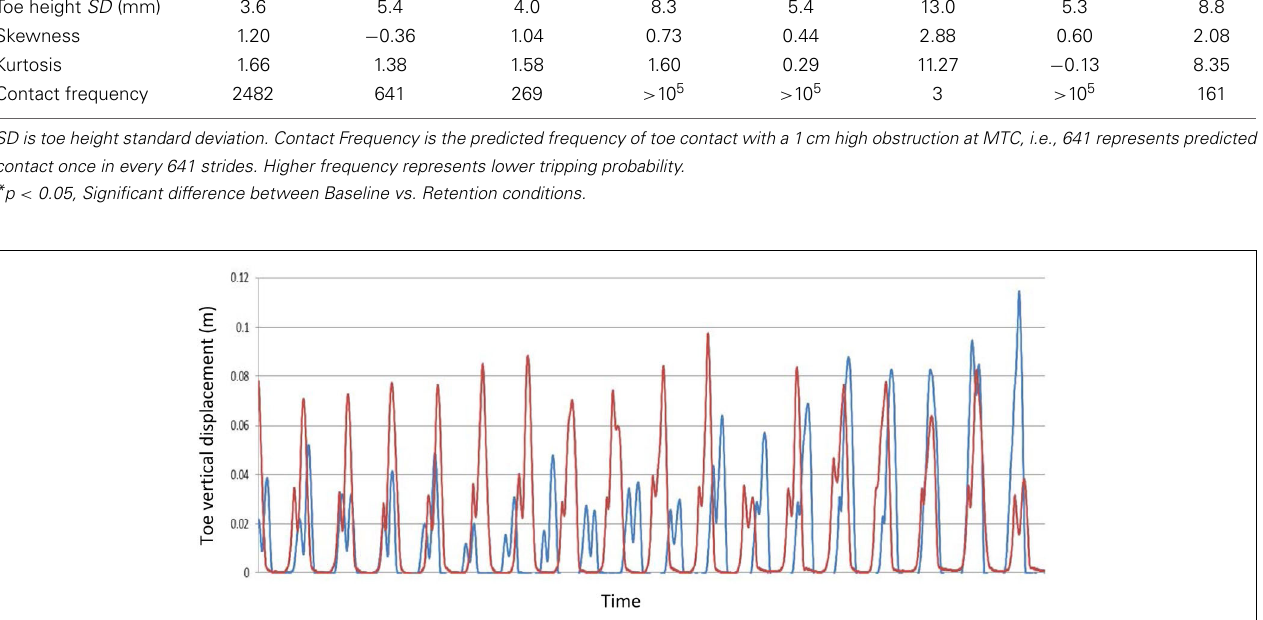
FIGURE 2 | A sample of the real-time vertical toe-ground displacement for the Stroke Participant during preferred speed treadmill gait training, Blue—Pre-training; Red—Post-training